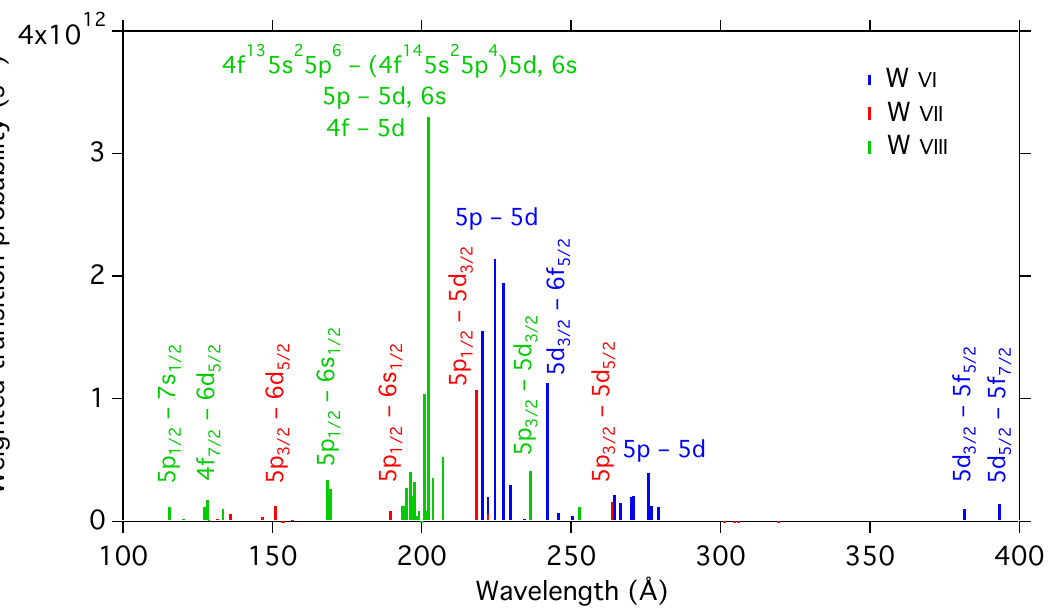
Figure 5. Wavelengths and weighted radiative transition probability rates for transitions to the ground configurations in W VI – VIII . Cowan calculations courtesy of U.I.